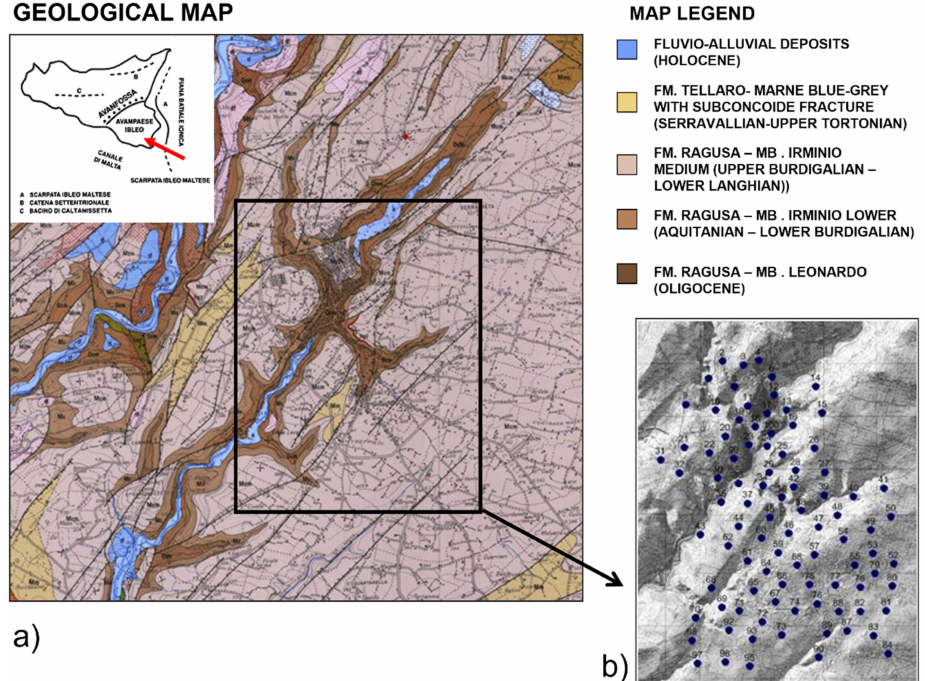
Figure 5. ( a ) Geological map of the Modica territory [45], modified; ( b ) location of the microtremor measure